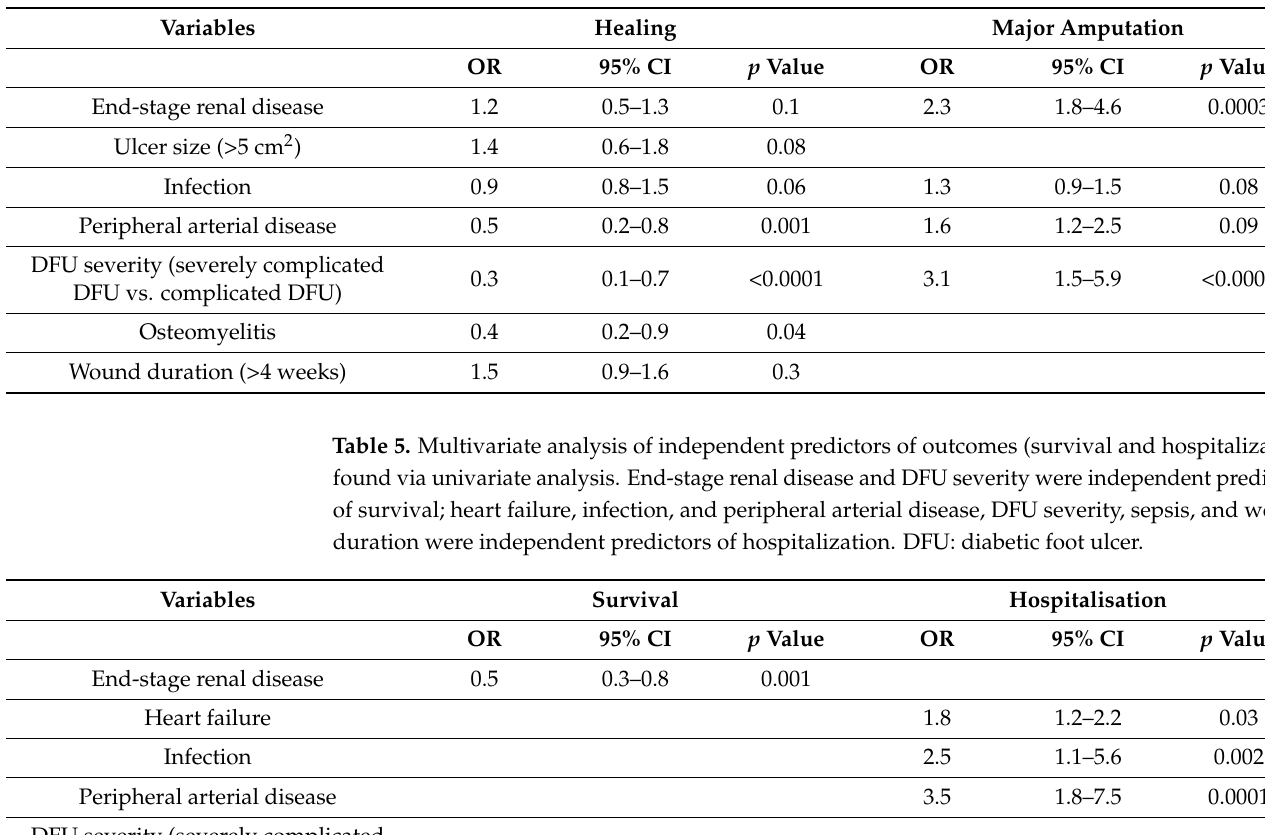
Table 4. Multivariate analysis of independent predictors of outcomes (healing, major amputation) found via univariate analysis. Peripheral arterial disease, DFU severity, and osteomyelitis were independent predictors of healing; end-stage renal disease and DFU severity were independent predictors of major amputation. DFU: diabetic foot ulcer.